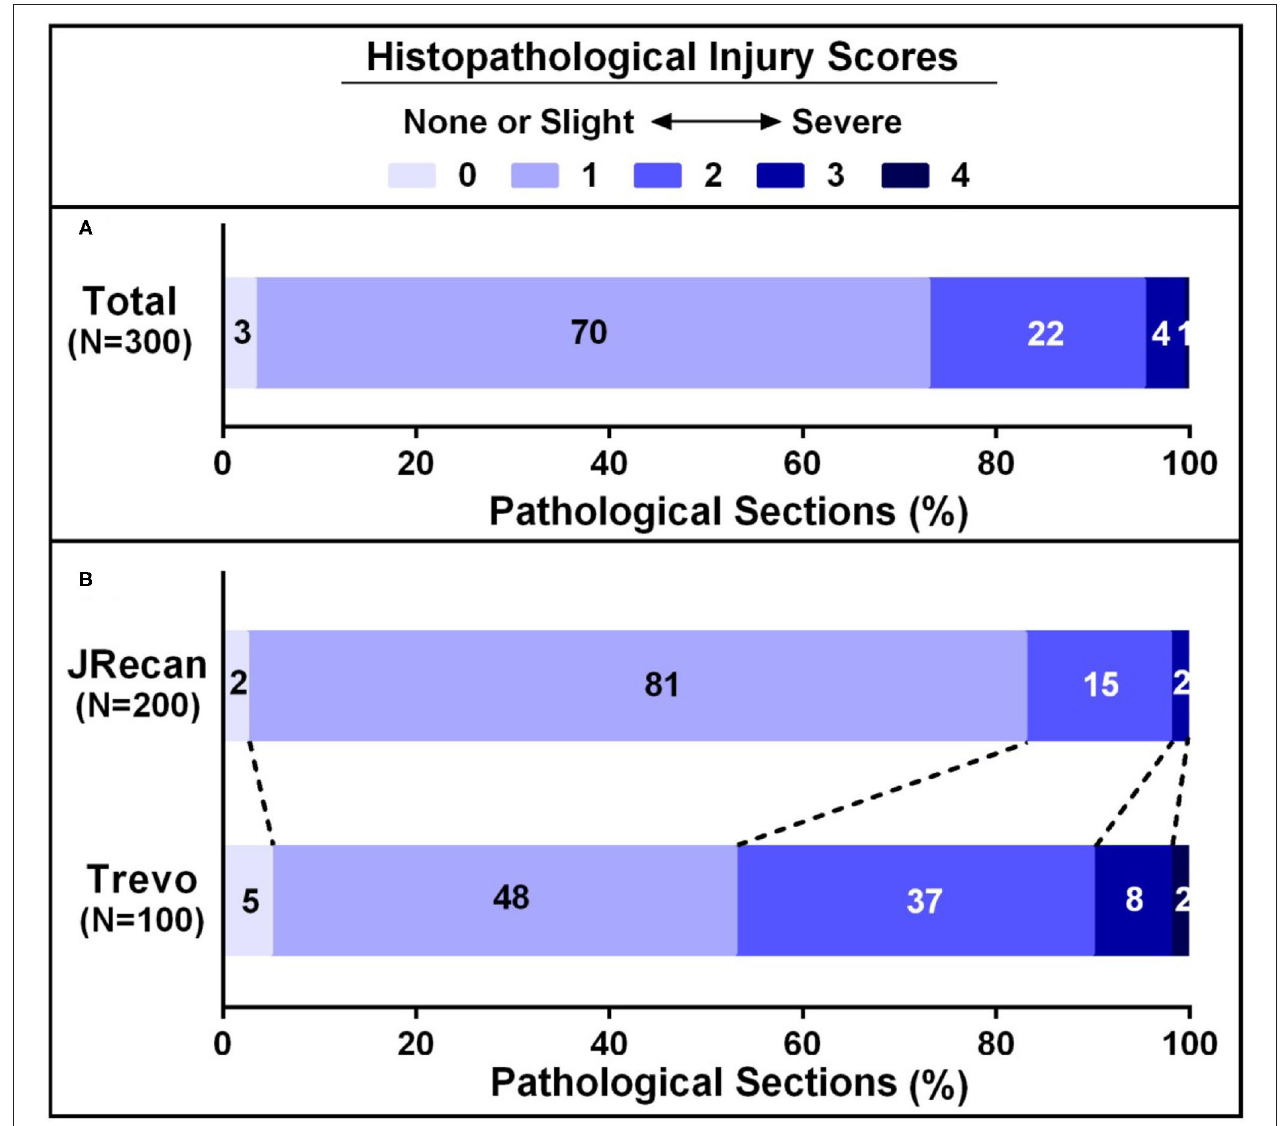
FIGURE 4 | Histopathological injury scores of carotid arteries underwent Jrecan and Trevo thrombectomy. (A) Overall histopathological lesion score of carotid injury underwent Jrecan and Trevo thrombectomy. (B) Histopathological lesion score of carotid injury with respect to different thrombectomy devices. Data were presented as a percentage of the number of samples in each score to the total numbers of corresponding samples. Significance was determined by Wilcoxon rank-of-rank